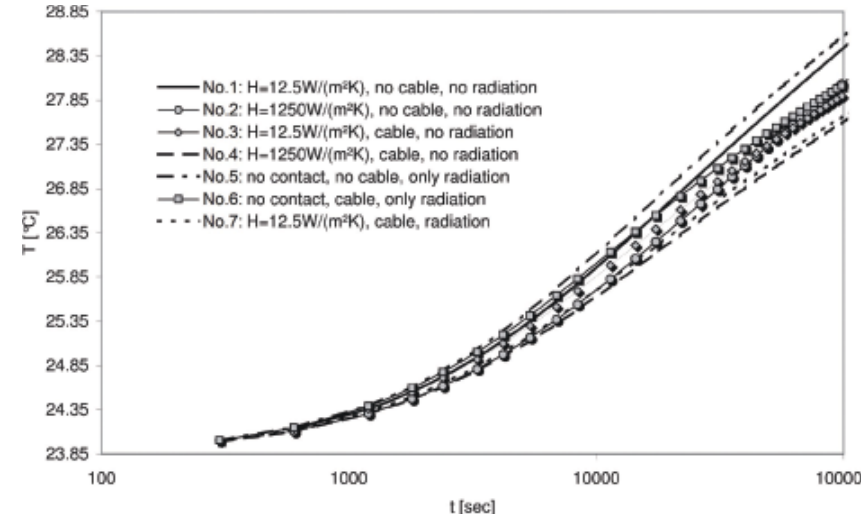
Fig. 14. Temperature response of the hollow cylindrical LNP01-sensor at the measurement point due to heating in a low conductivity sample with λ = 0 . 02Wm − 1 K − 1